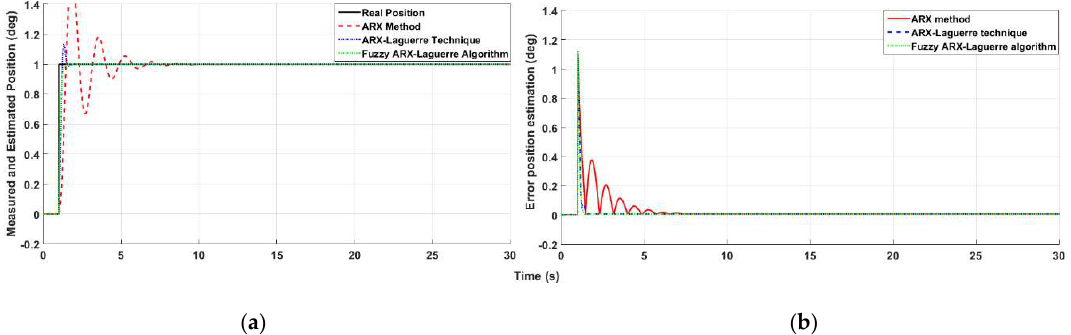
Figure 8. Proposed fuzzy ARX-Laguerre method, ARX-Laguerre technique, and ARX algorithm for position estimation of the surgical robot for the sinus under normal conditions. ( a ) Measured and estimated position. ( b ) Error of estimated position.